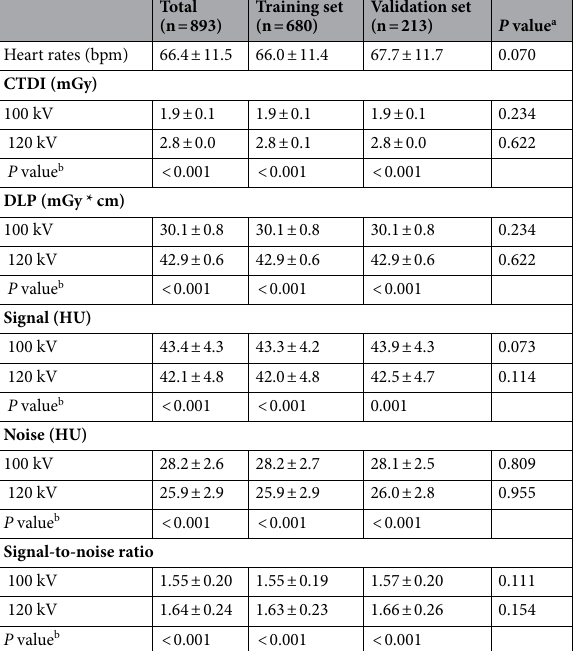
Table 2. CT characteristics of participants in the training and validation sets. Data are means ± standard deviations. CTDI volumetric CT dose index, DLP dose-length-product. a Between the training set and validation set. b Between the 100-kV and 120-kV